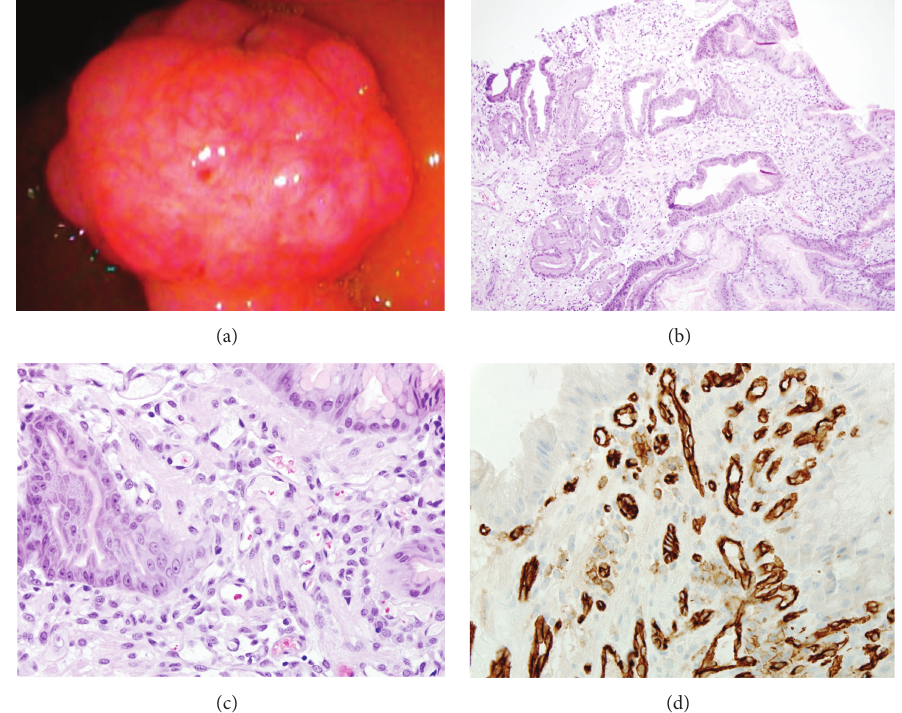
Figure 2: Pyogenic granuloma of the stomach (Case 2 ). (a) Endoscopic appearance of the 12mm gastric polypoid nodule with surface erosions. (b-c) Histologically, a capillary hemangioma is present and arranged in a lobular pattern and filled with clusters of small capillary vessels and neutrophils infiltrate ((b), × 100; (c), × 400). (d) Immunohistochemistry of CD31 highlighting the capillary proliferation ( ×